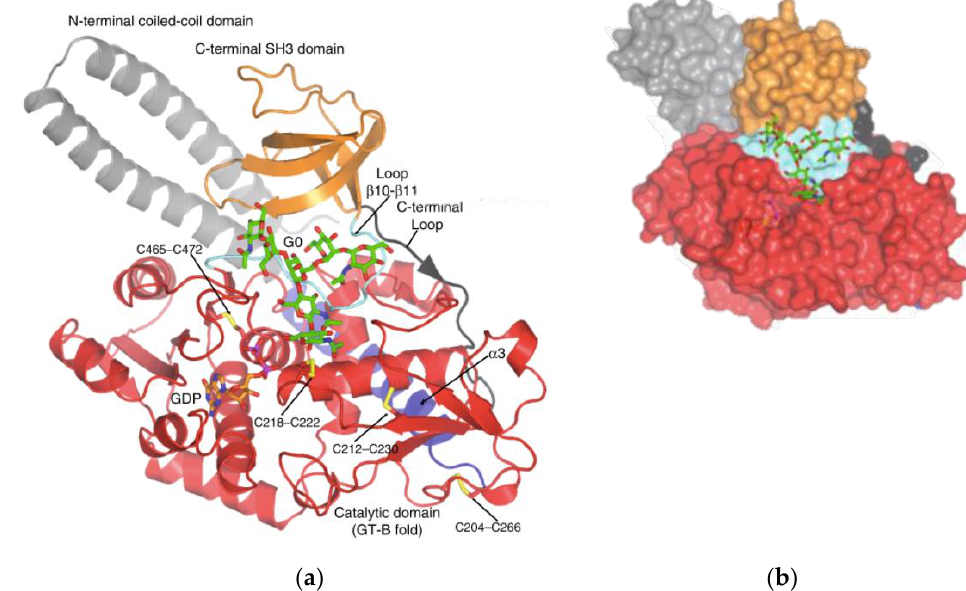
Figure 3. Structure of FUT8. Published by [43] and reproduced with permission. ( a ) Ribbon structure of HsFUT8 with orange carbon atoms representing GDP and green carbon atoms representing a bi-antennary complex N-glycan (G0). The coiled-coil domain is colored in gray, the catalytic domain in red, and the SH3 domain in orange. The interdomain α3 and loop β10–β11 are colored in blue and aquamarine, respectively. Yellow sulfur atoms indicate disulfide bridges. The C-terminal loop is colored in black. Electron density maps are F O –F C (blue) contoured at 2.2 σ for GDP and G0. ( b ) Surface representation of the HsFUT8-GDP-G0 complex.